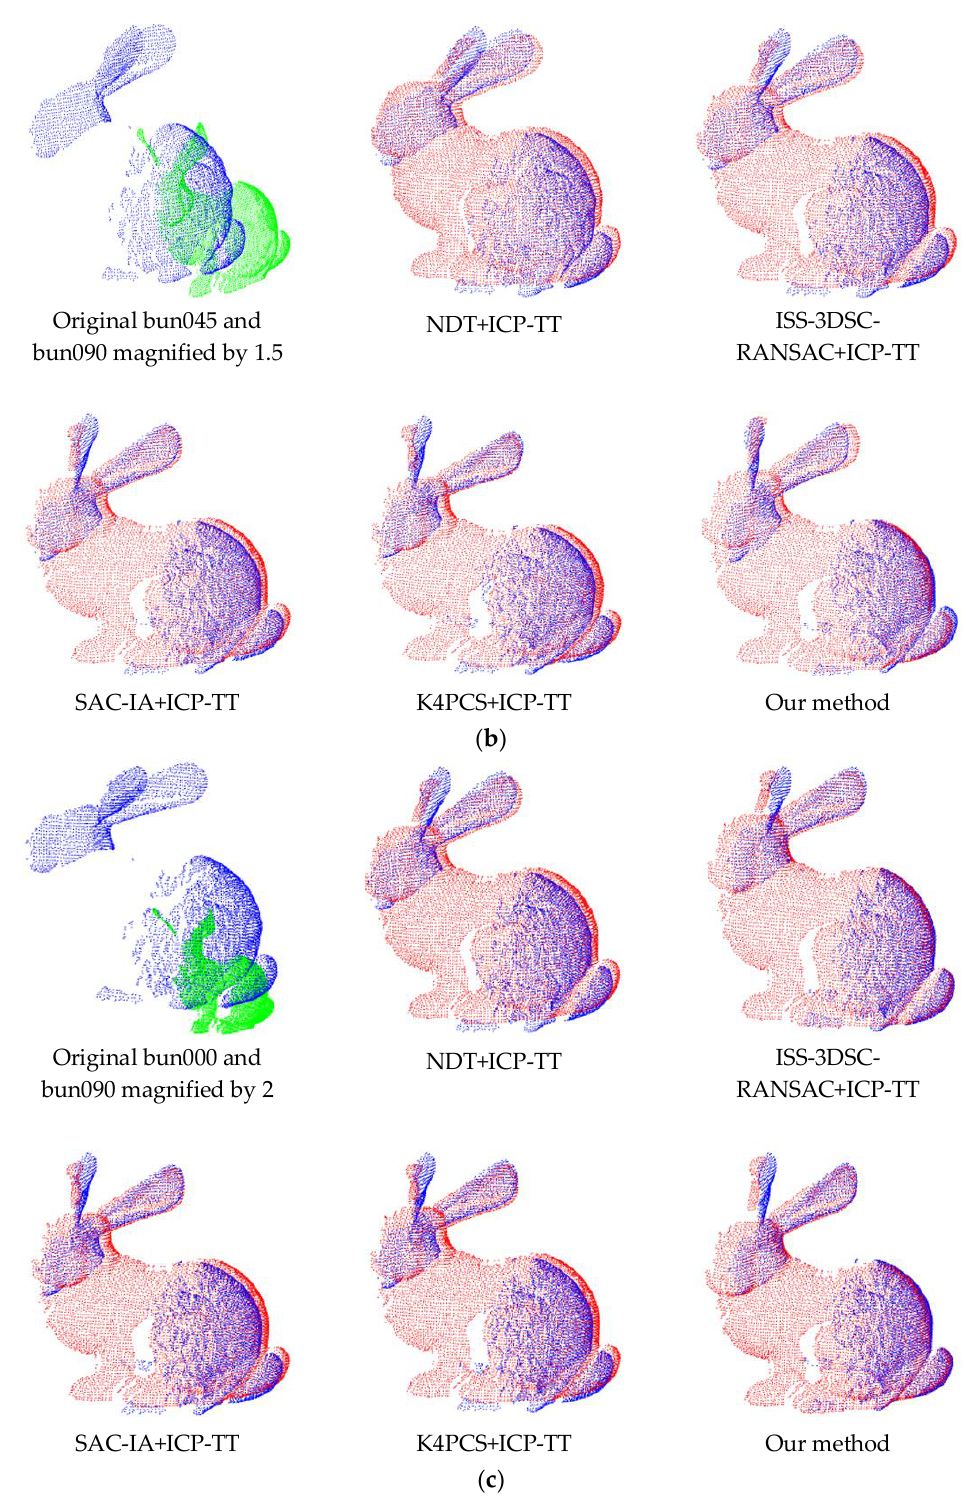
Figure 13. The registration results for scaled bunny rabbit data set of multiple registration methods with TT strategy. ( a ) The bun045 and bun090 magnified by 0.5 and registration results of five coarse- to-fine registration methods with TT strategy. ( b ) The original bun045 and bun090 magnified by 1.5 and registration results of five coarse-to-fine registration method with TT strategy. ( c ) The original bun045 and bun090 magnified by 2 and registration results of five coarse-to-fine registration method with TT strategy.